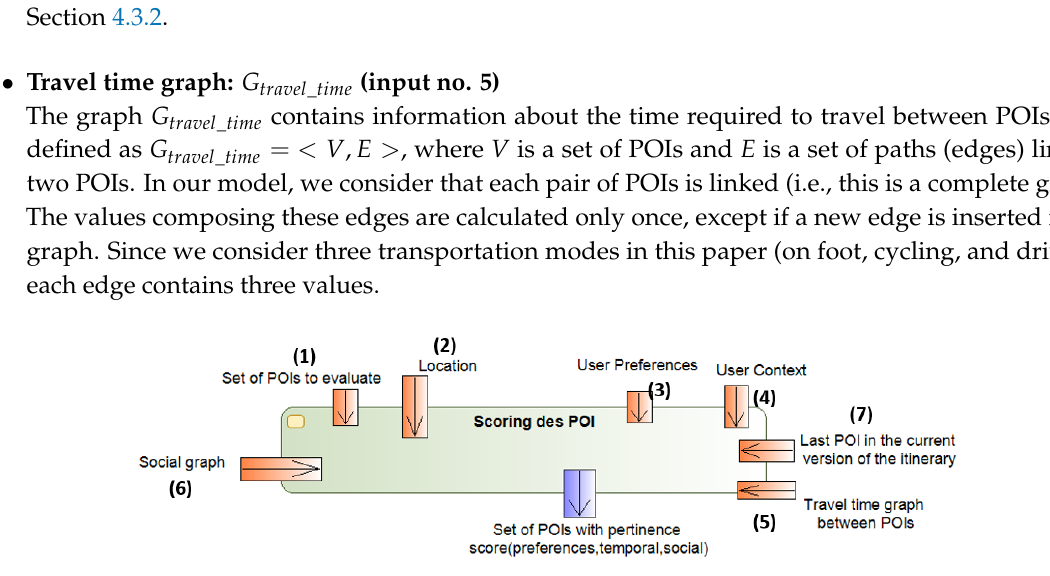
Figure 11. Input and output of the scoring function.